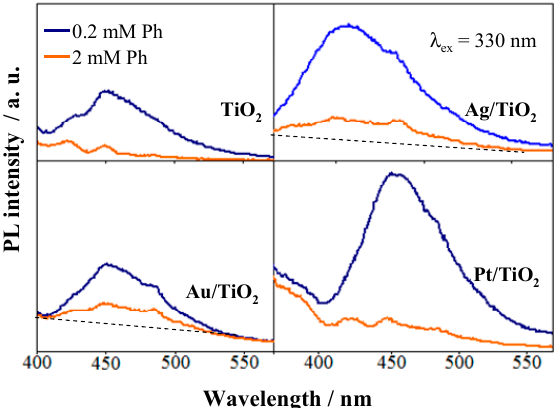
Figure 10. The survey of OH formation in low (trace 0.2 mM Ph) and high Ph concentration (trace 2 mM Ph) over photocatalyst exposed to simulated solar light for 30 min. Experimental conditions: 0.6 mg photocatalyst was dispersed by ultrasonication in 40 mL solution of coumarin (11 mM)-Ph (0.2 mM) (blue trace 0.2 mM). In second case, the concentration of Ph in 11 mM coumarine solution was increased to 2 mM (orange trace 2 mM).